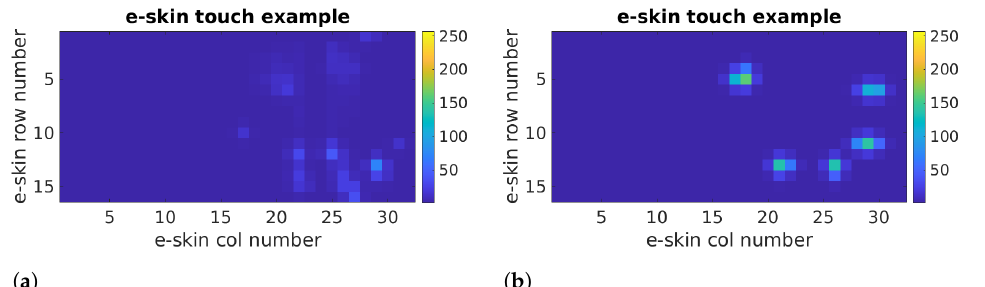
Figure 3. Example hand touch visualisation for the size of 16 × 32 cells; Gaussian blur used for post- processing. ( a ) Example hand touch. ( b ) Example fingertips